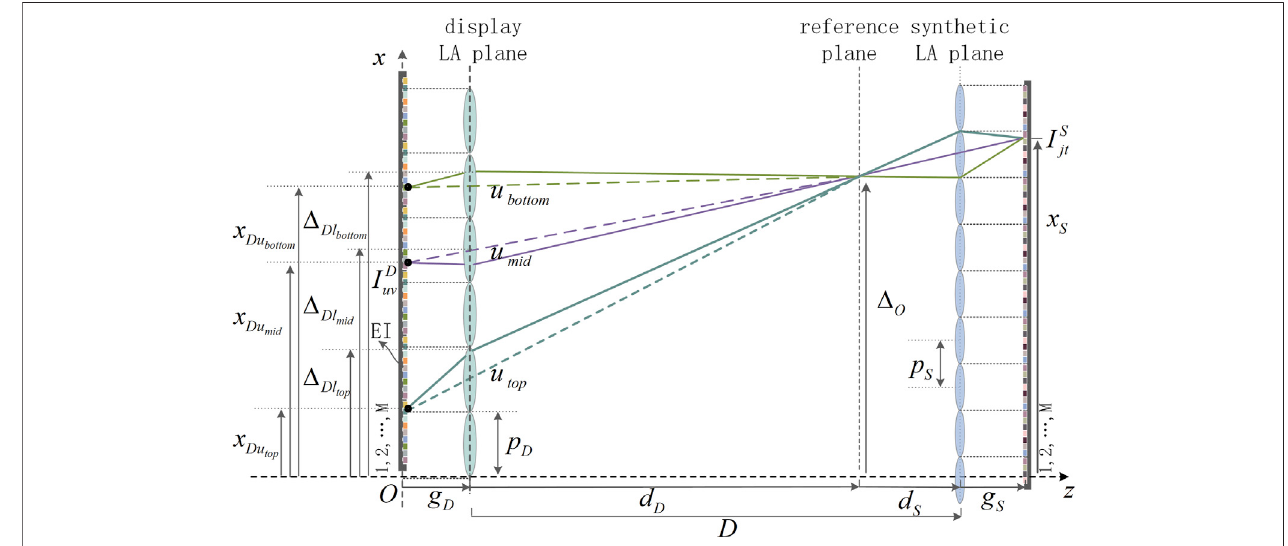
FIGURE 5 | Principle of the SPOC1